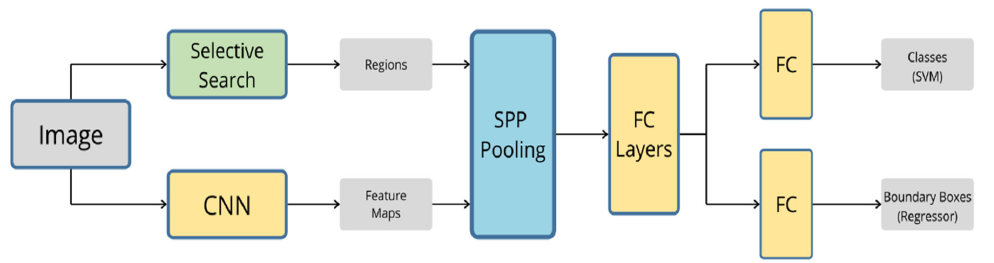
Figure 11. The architecture of spatial pyramid pooling (SPP-Net) algorithm.